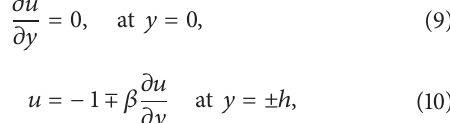
Figure 1: Geometry of nonuniform peristaltic